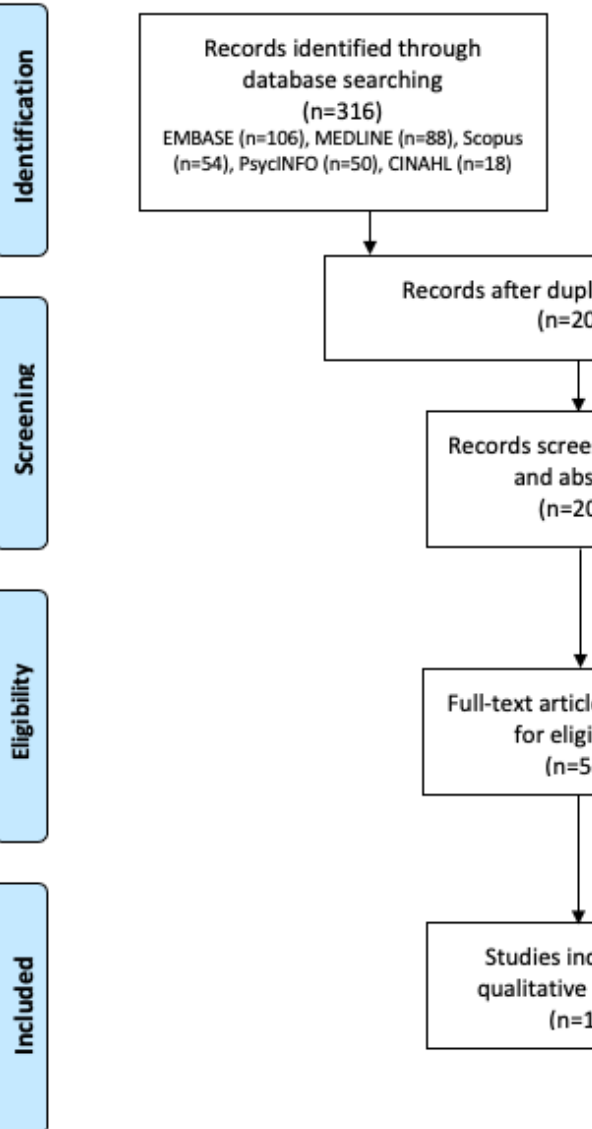
Figure 1. PRISMA (Preferred Reporting Items for Systematic Reviews and Meta-Analyses) flow diagram of included